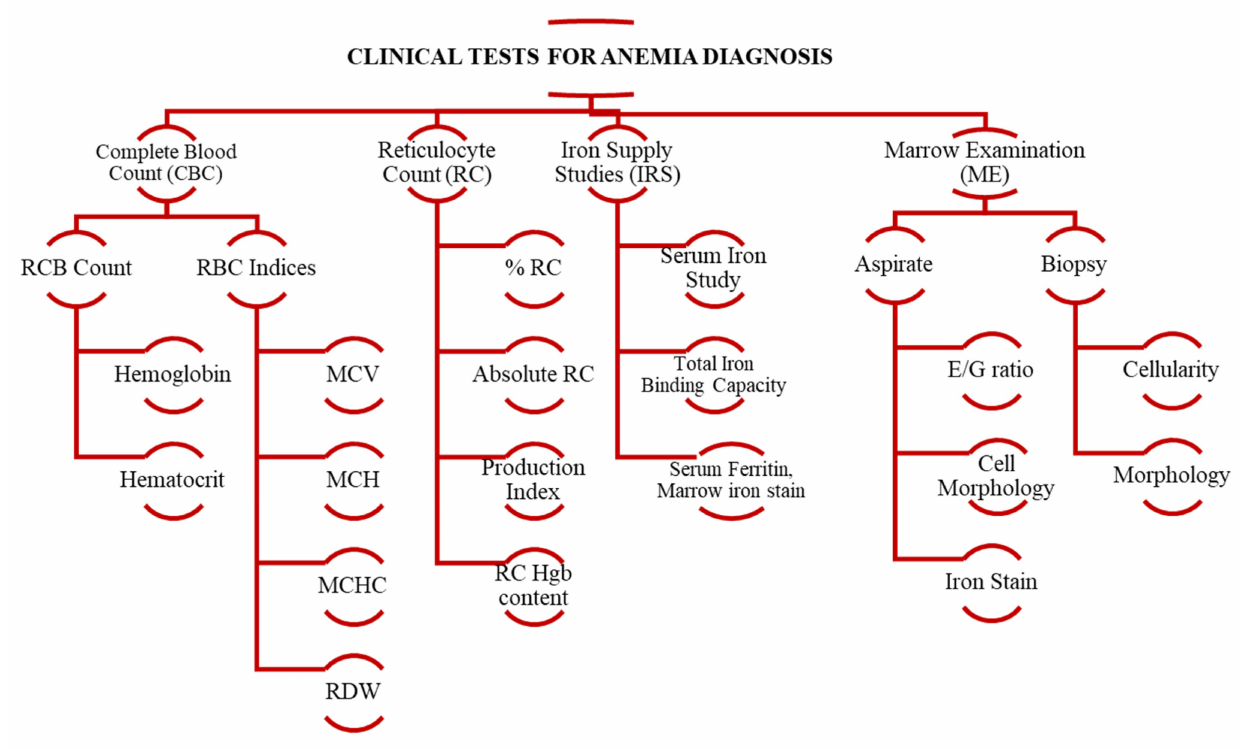
Figure 1. Clinical tests used for the diagnosis of